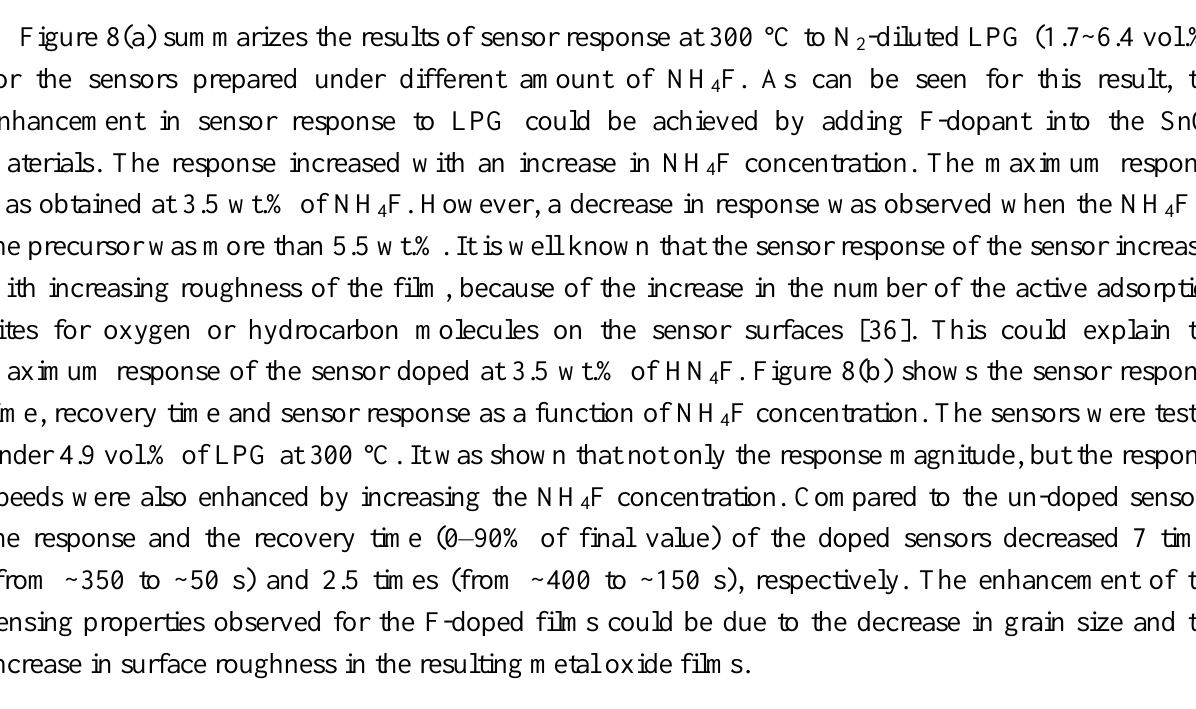
films deposited at different amount 2